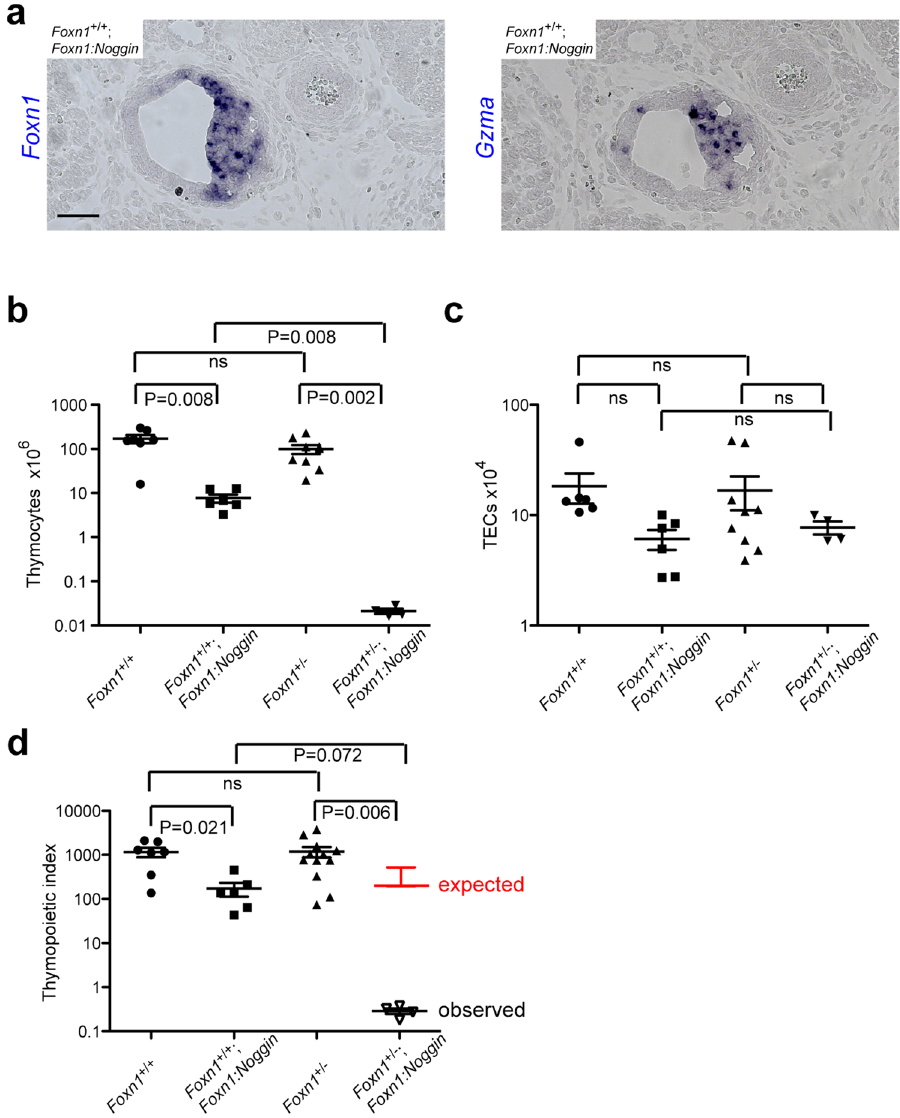
Figure 2. Thymopoietic activity in the rudiment of Foxn1:Noggin transgenic mice. ( a ) RNA in situ hybridization of the thymic rudiments of Foxn1 + / + ; Foxn1:Noggin transgenic embryos at E15.5; positive cells are stained blue. The probes used are indicated to the left; genotypes are indicated in the top left corner. Scale bar, 100 μ m. ( b ) Number of CD45 + thymocytes. Intrathymic T cell development is qualitatively normal in transgenic mice (Supplementary Fig. 5). ( c ) Number of thymic epithelial cells (TECs). ( d ) Thymopoietic indices, calculated as thymocyte/TEC ratios. The mean + s.e.m. value expected under the multiplicative model of epistasis 22 is indicated in red; the difference to the observed values is estimated to be significant at P < 0.01. In ( b ) to ( d ), means ± s.e.m for 4-week-old